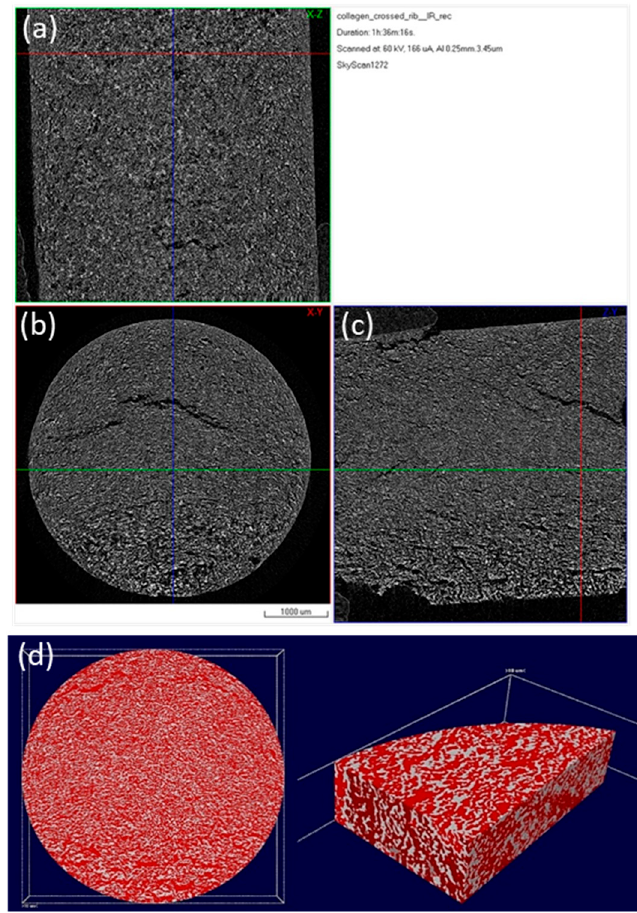
Figure 7. Micro-CT images of a 3D hybrid scaffold crosslinked with 0.01% riboflavin: Reconstructed results visualized as a set of orthogonal slices crossed at selected points ( a ) XZ cross section, ( b ) XY cross section (perpendicular to Z axis of the specimen), ( c ) ZY cross section, ( d ) 3D surface rendered model from micro-CT scan presenting internal porosity (red) in specimen volume (white).